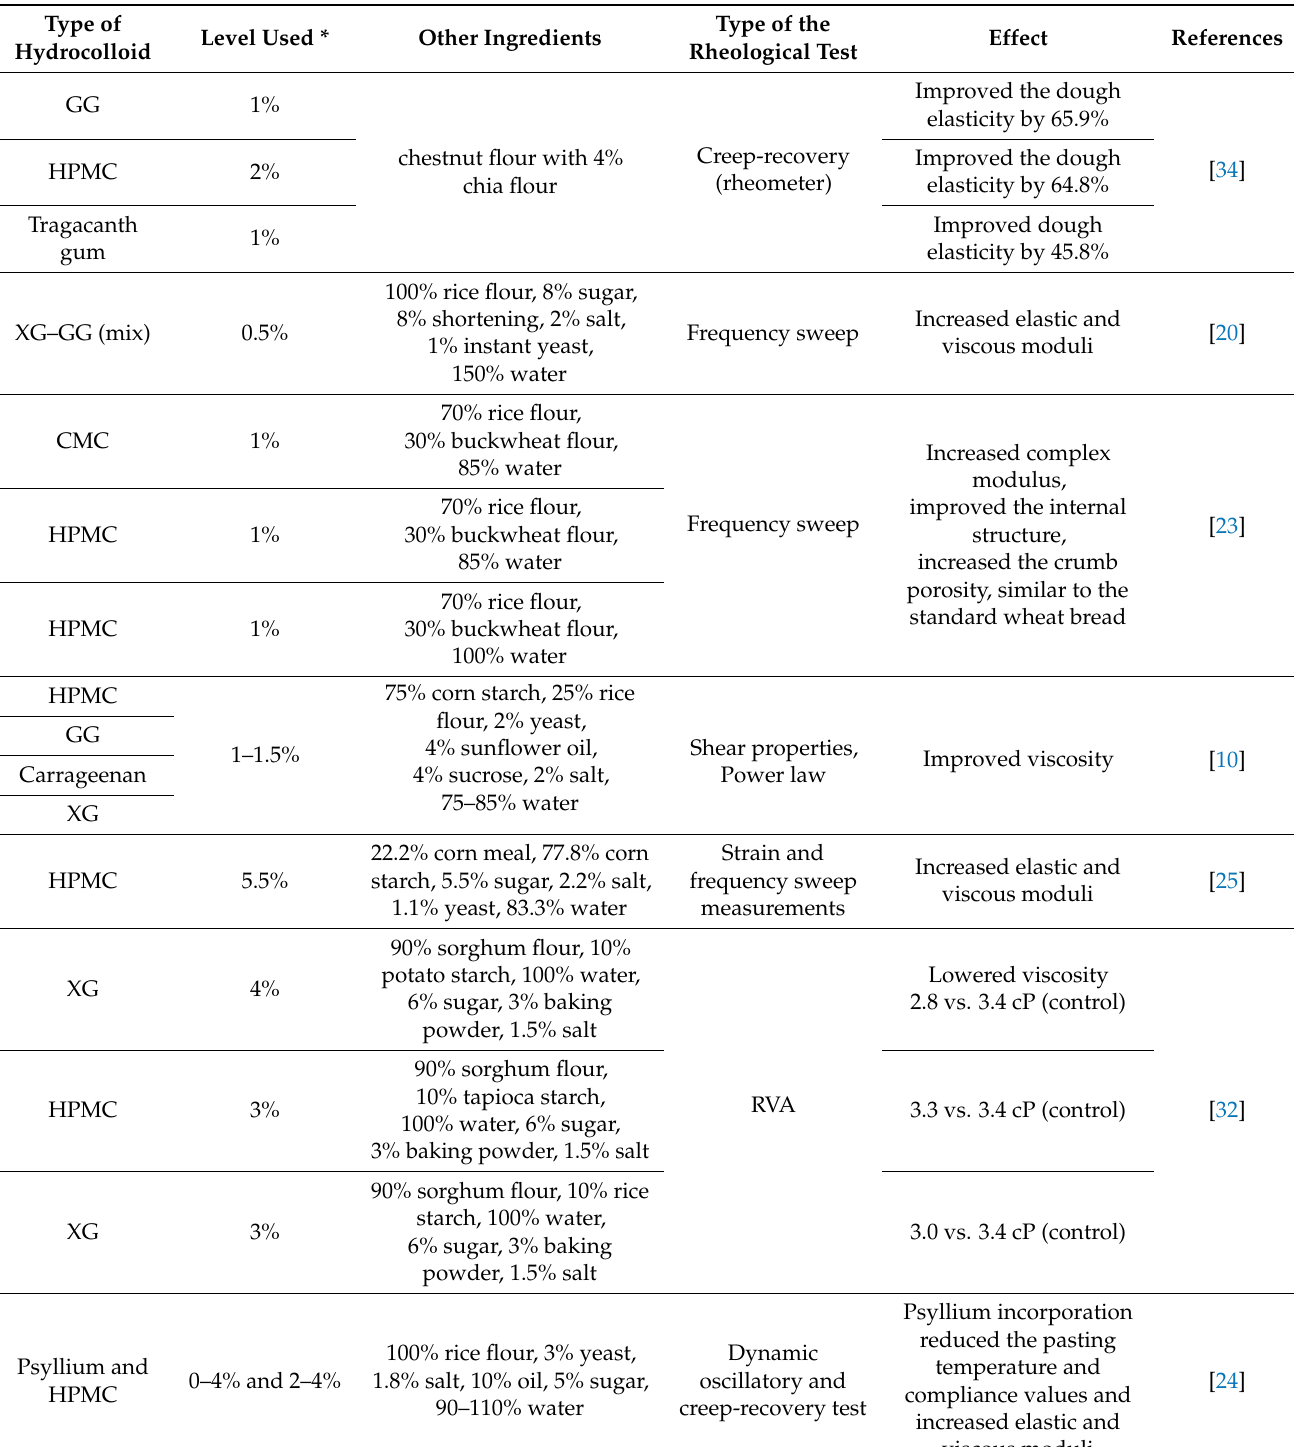
Table 1. Effect of hydrocolloids on dough